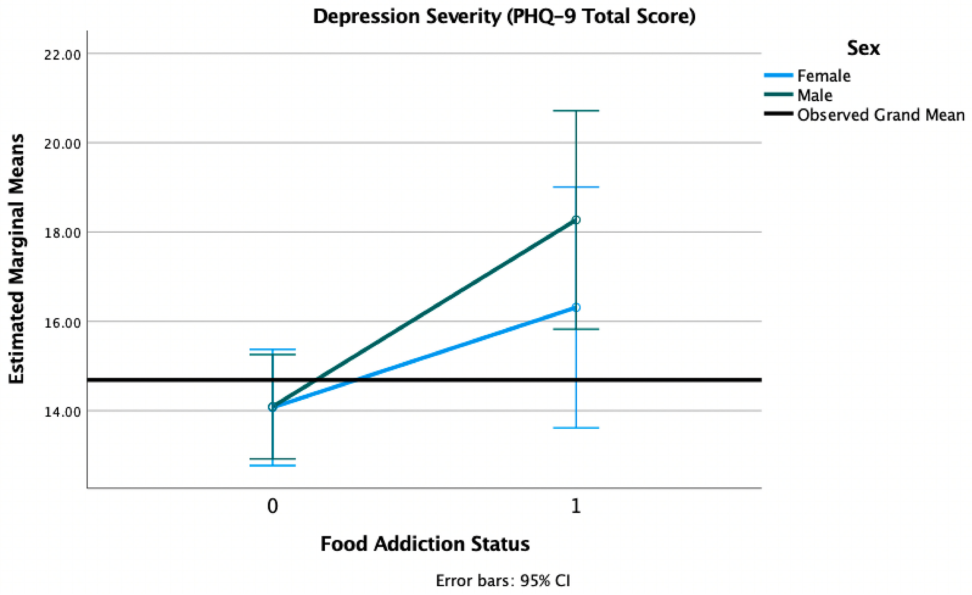
Figure 5. Estimated marginal means of depression severity for a 2 × 2 factorial ANOVA with sex (female, male) and FA status (1 = positive, 0 = negative, on the X -axis) adjusted for age, race, and PTSD status (threshold vs. subthreshold). Note: PHQ-9 = Patient Health